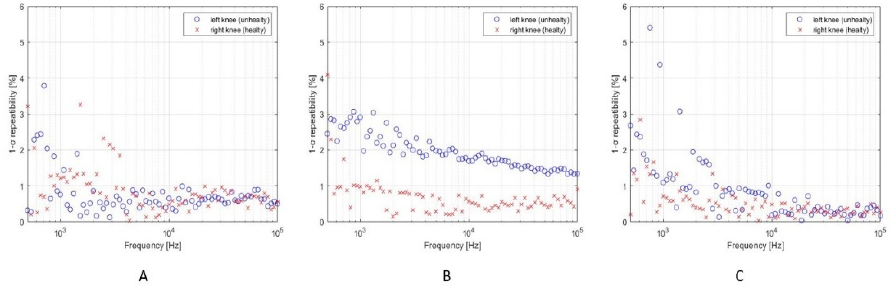
Figure 9. Impedance magnitude 1- σ repeatability values for both right (healthy) and left (unhealthy) knee before surgery ( A ), one week after surgery ( B ), and one month after surgery ( C ).